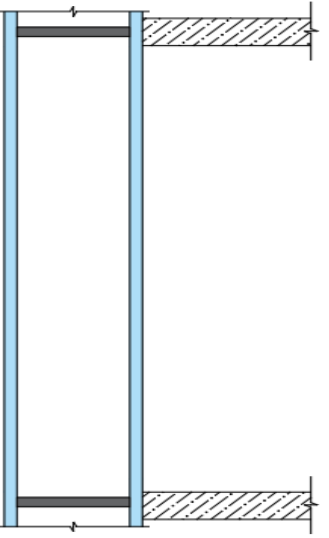
Figure 13. Facade systems with closed air layers (buffer zones).